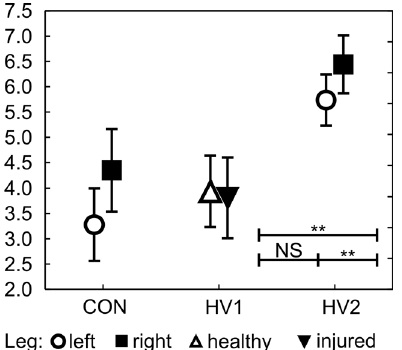
Fig.6 Minimum hip adduction (in deg) during the gait